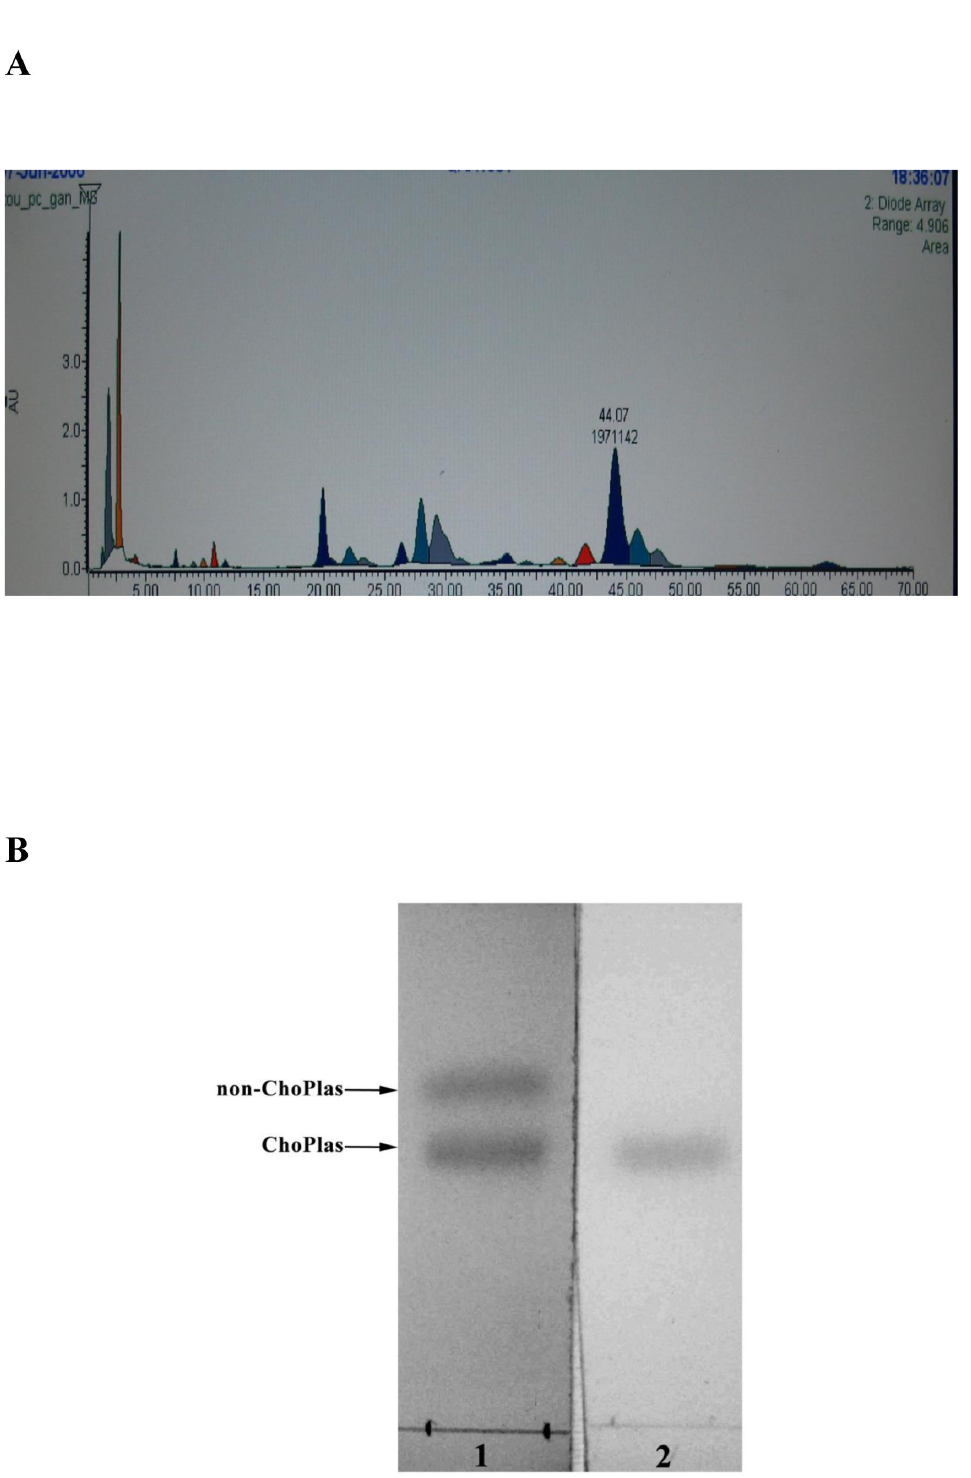
Figure 1. Purification and Identification of ChoPlas. A , Chromatogram of PC compositions . Kromasil C18 column; mobile phase, methanol-hexane-0.05 mol/L ammonium acetate-glycerol (V/V); column temperature, 35°C; injection, 20 μL; detection wavelength, 206 nm; flow rate, 1.0 ml/min; B , High Performance Thin Layer Chromatogram of ChoPlas . ChoPlas separated by HPLC was applied to the TLC plate and developed with chloroform/methanol/water (60:25:4, v/v, plate 1 bands were visualized by I vapor and plate 2 bands were visualized by 5 nmol/L HgCl. doi: 10.1371/journal.pone.0077387.g001 PLOS ONE |